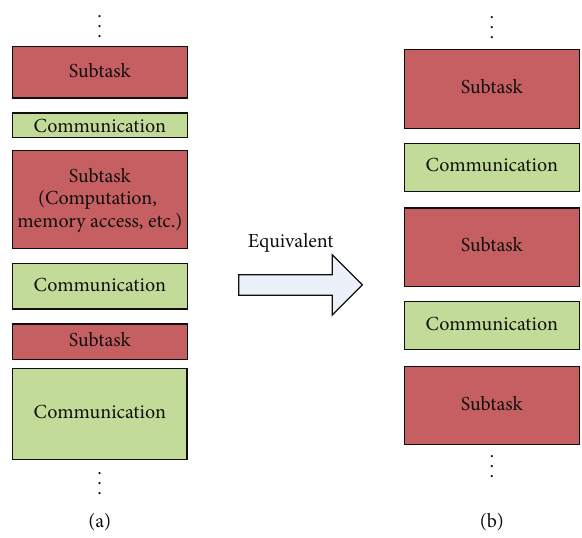
Figure 2: The subprogram running on a processor node